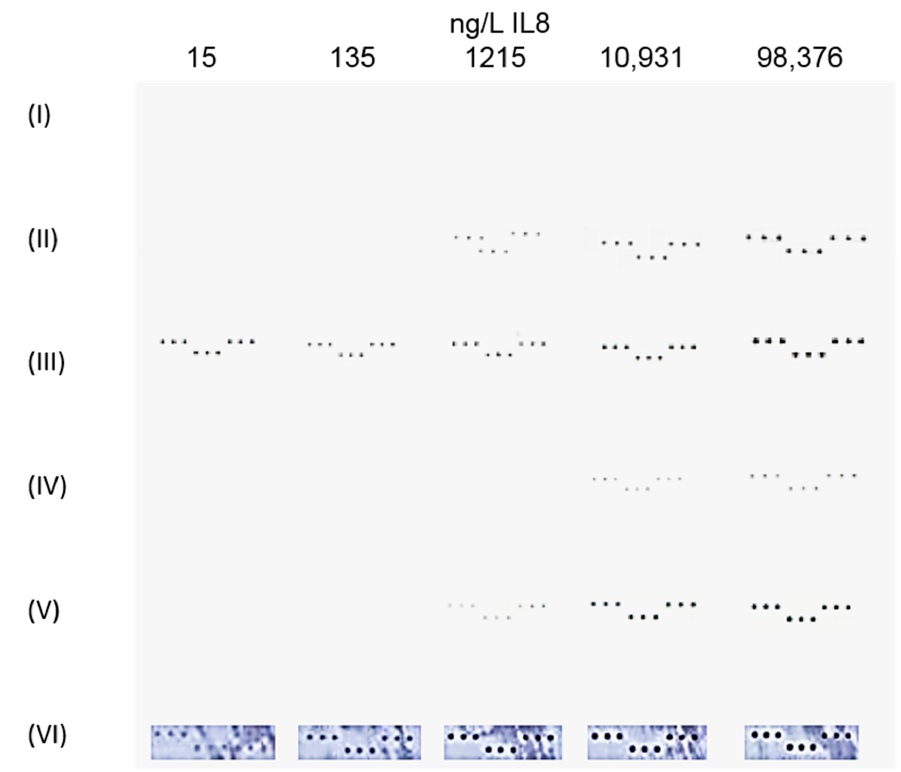
Figure 2. JPEG images of colorimetric subarrays after incubation with different labels based on Formats (I)–(VI). The corresponding IL8 concentrations are indicated in the columns as 15, 135, 1215, 10,931, and 98,376 ng/L.